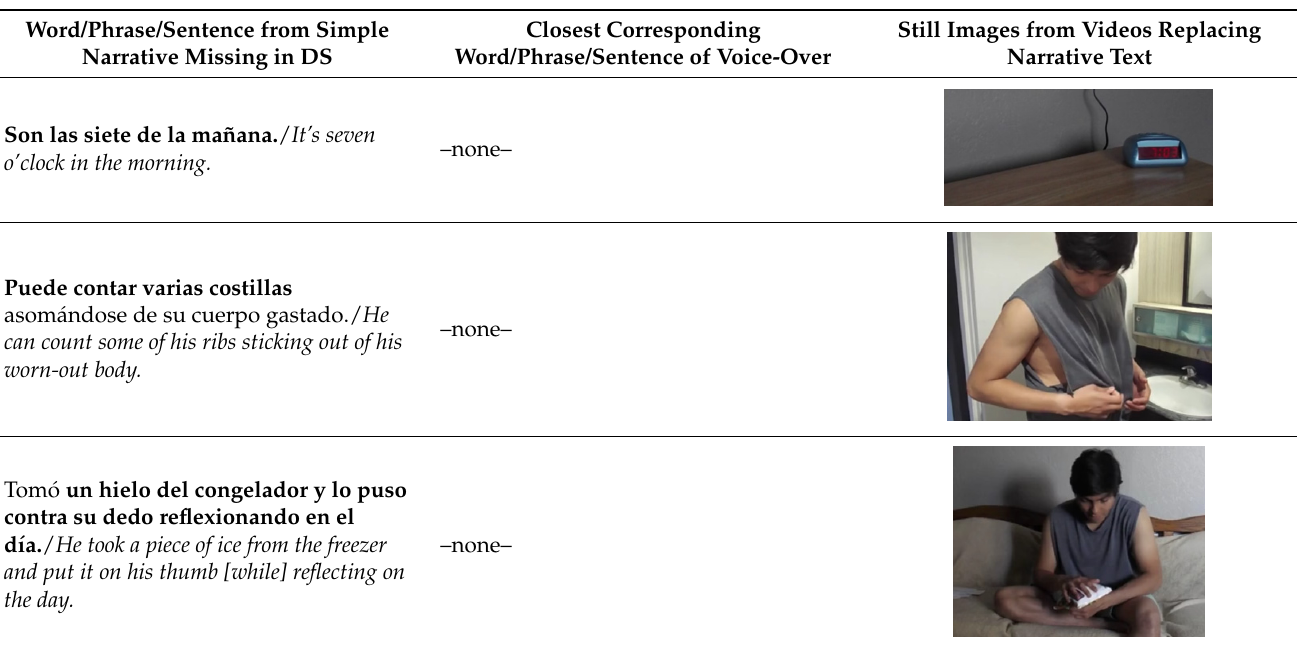
Table 9. Examples of Sofia’s transduction using self-produced video footage.